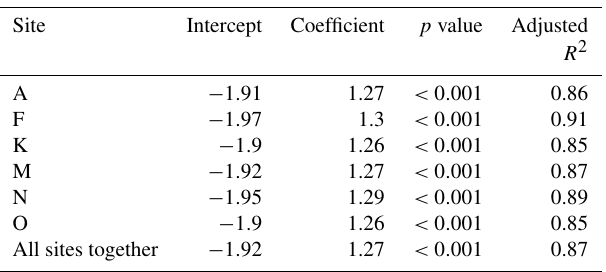
Table 4. Logarithmic regression between distance from the tree edge and increasing snow depth within a 10m buffer toward the open. The p values > 0 . 001 are described as not significant.